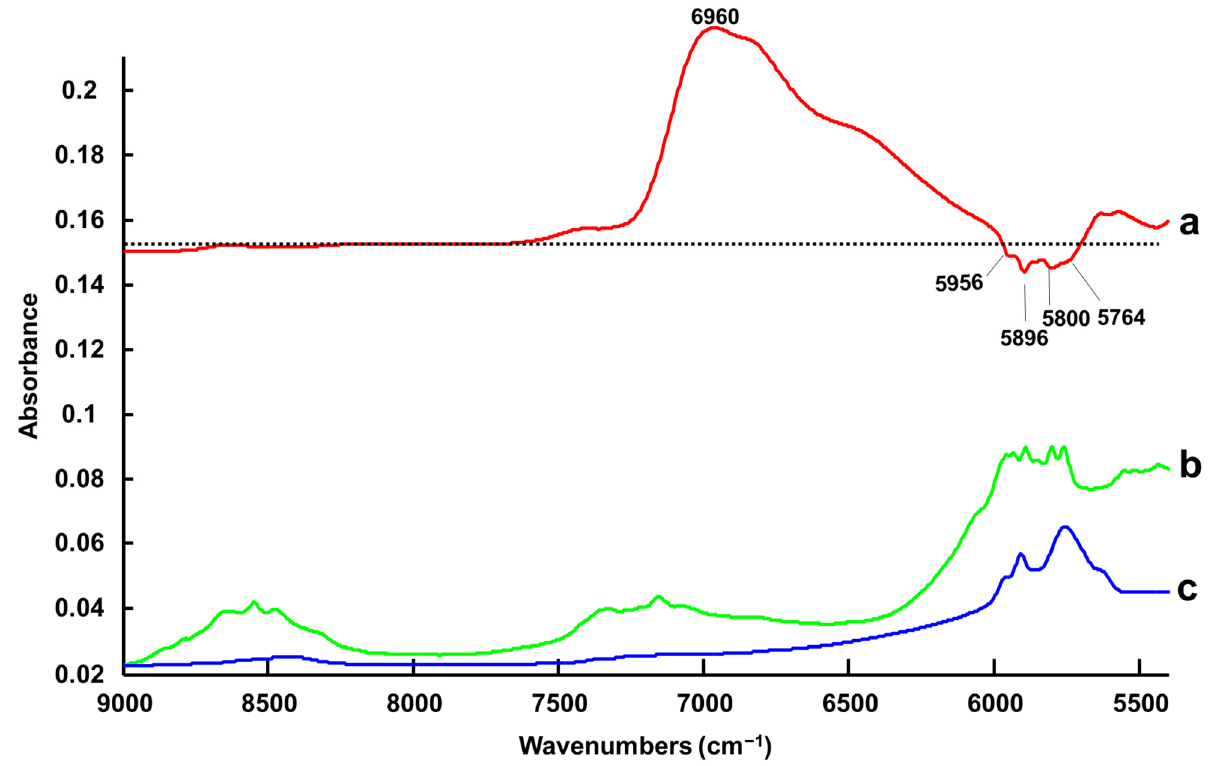
Figure 5. First regression coefficients from PLSR of NIR-B (dotted line indicates the zero baseline) ( a ) compared to the spectra of L-Proline ( b ) and Levulinic Acid ( c ). Spectra have been offset for clarity.